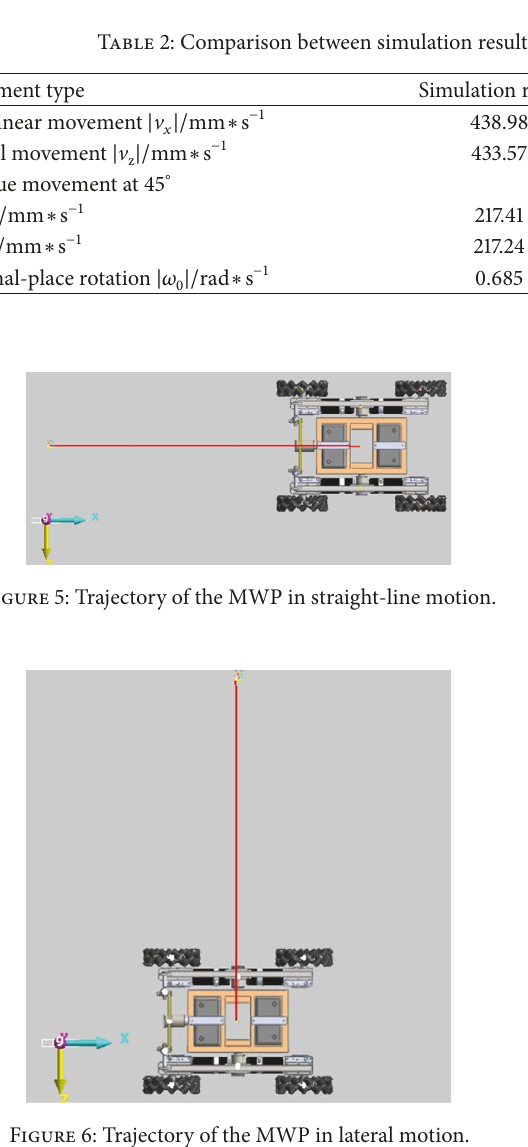
Figure 6: Trajectory of the MWP in lateral motion.